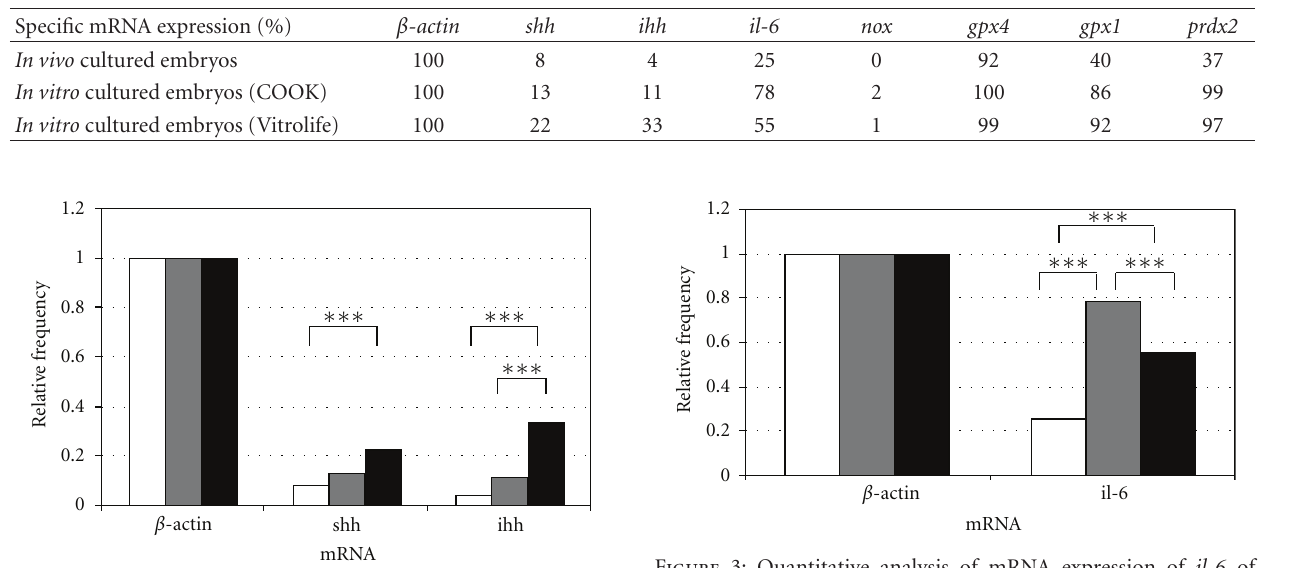
Figure 1: Overview representing experimental time course from stimulation of female mice, isolation of embryos, and their early development (modified after [8]). Table 3: Frequency of detection of β -actin, shh, ihh, il-6, nox, gpx4, gpx1, and prdx2 mRNA in single murine blastocyst with β -actin as internal standard.